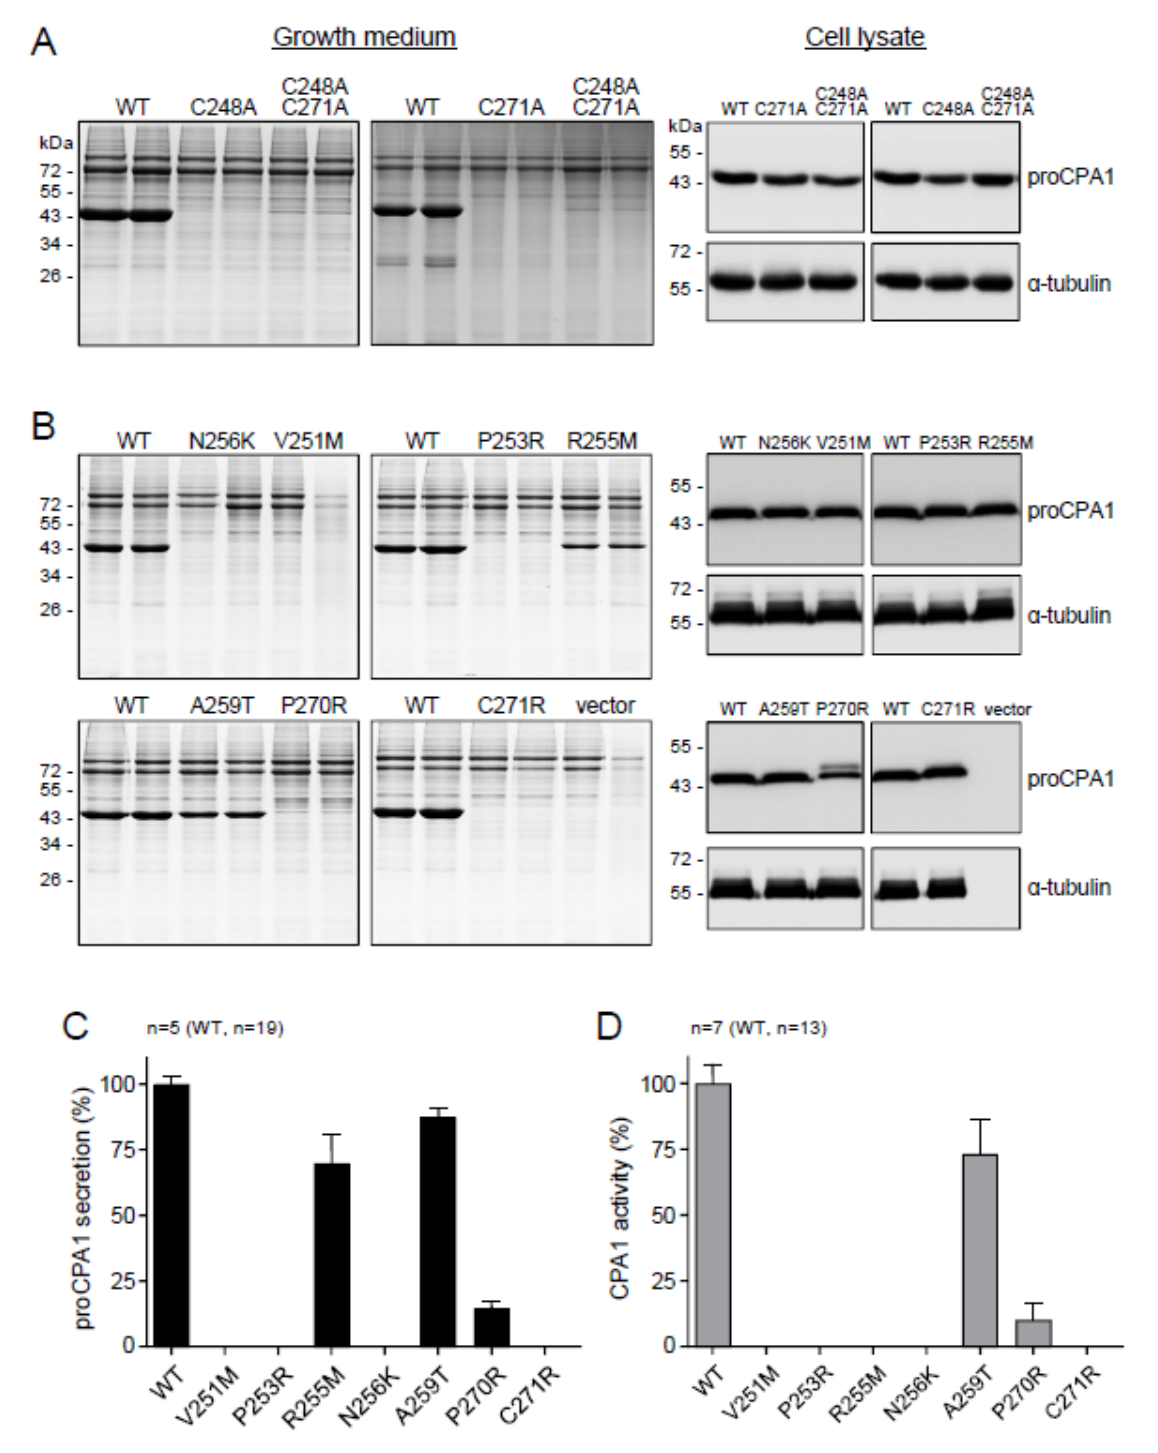
Figure 4. Effect of CPA1 variants on cellular secretion, intracellular protein levels, and enzyme activity. Secretion of proCPA1 protein from transfected HEK 293T cells was assessed by SDS-PAGE and Coomassie Blue staining. Protein levels of proCPA1 in cell lysates were analyzed by Western blotting. Alpha-tubulin was measured as loading control. ( A ) Effect of single Cys-mutations C248A and C271A, and double mutation C248A, C271A. ( B ) Effect of natural CPA1 variants p.V251M, p.P253R, p.R255M, p.N256K, p.A259T, p.P270R, and p.C271R. ( C ) Densitometric analysis of proCPA1 secretion to the growth medium. ( D ) CPA1 enzyme activity in the conditioned medium after activation of proCPA1. WT,